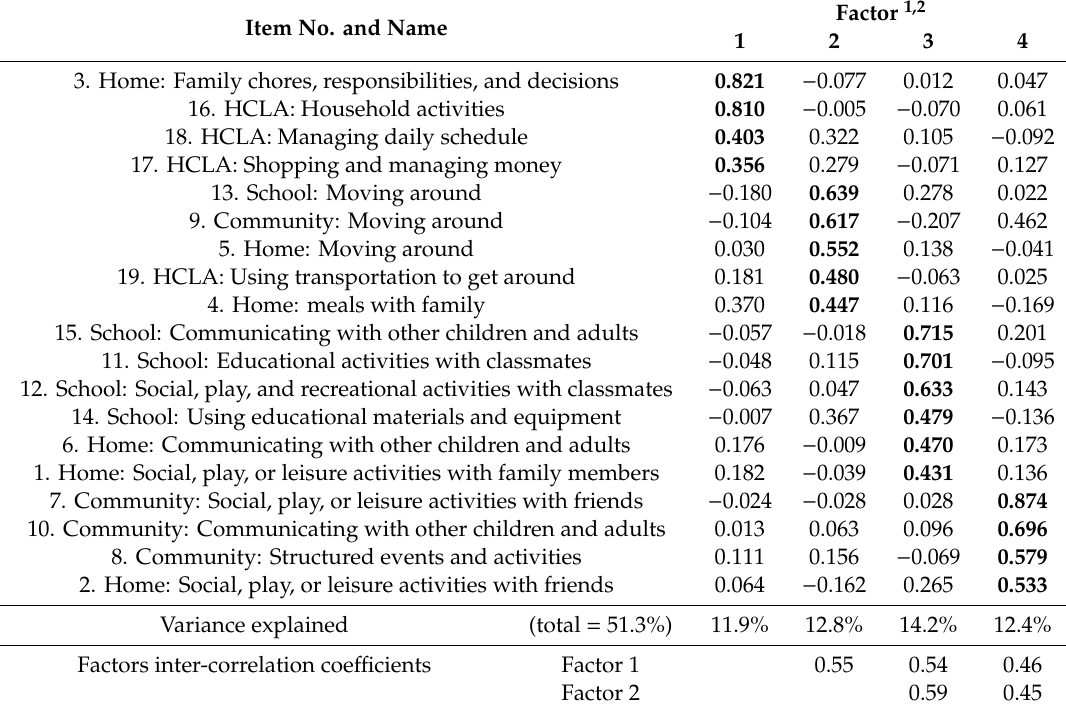
Table 3. Factor loadings of the frequency dimension of FUNDES-Child by exploratory factor analysis ( n =